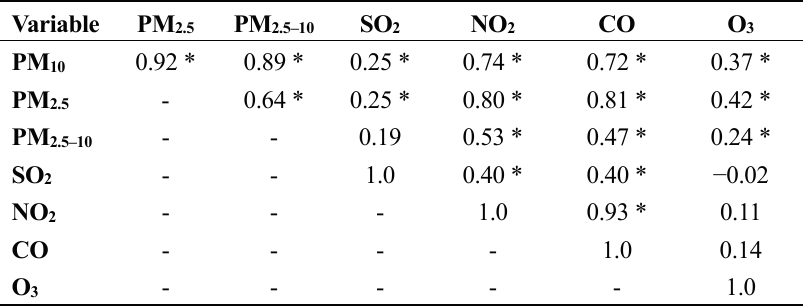
Table 2. Correlation coefficients among air